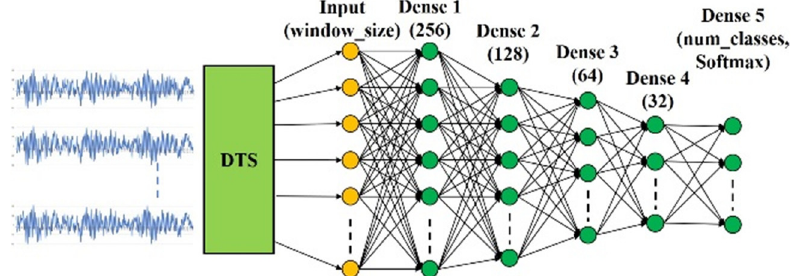
Figure 4: Proposed architecture of DTS –